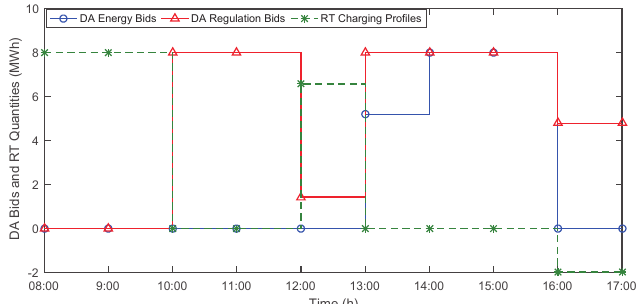
Figure 7. Optimal results in the day-ahead (DA) market under